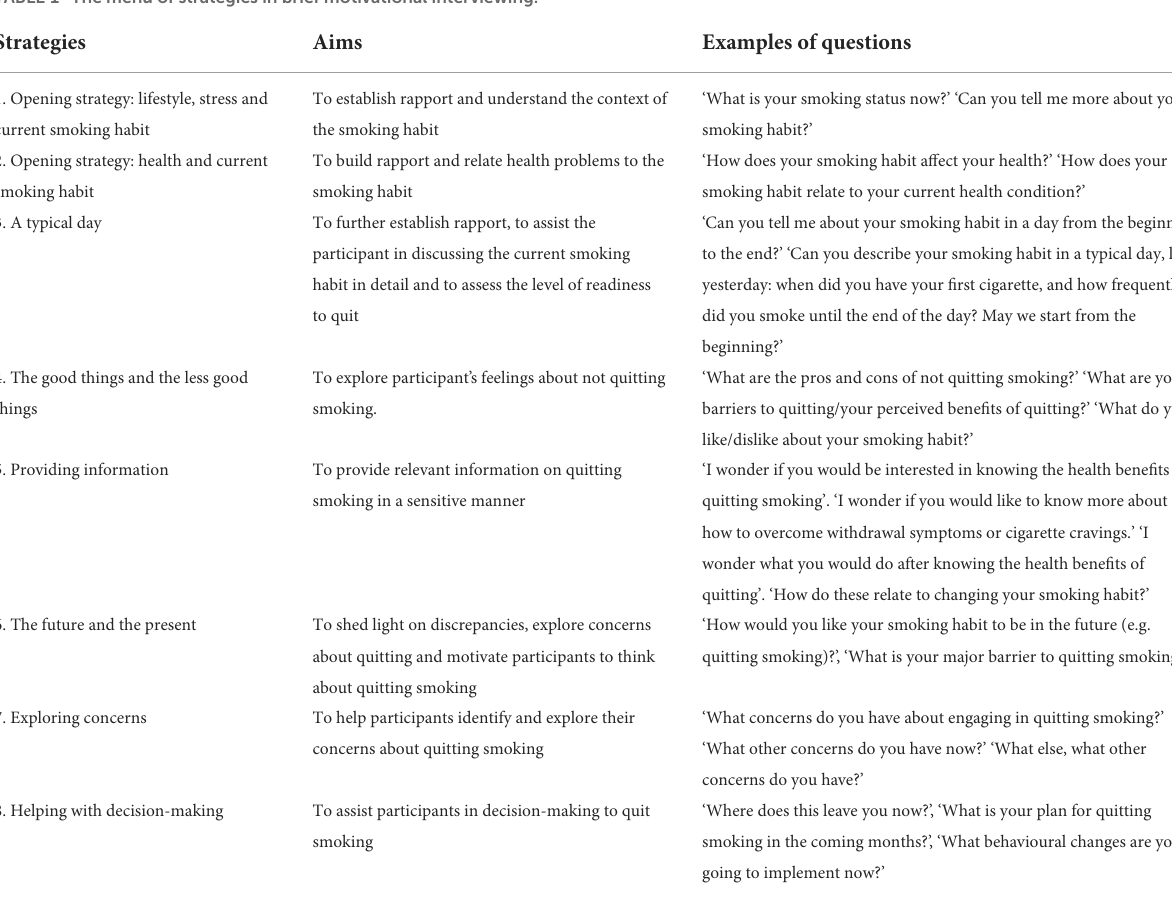
TABLE 1 The menu of strategies in brief motivational